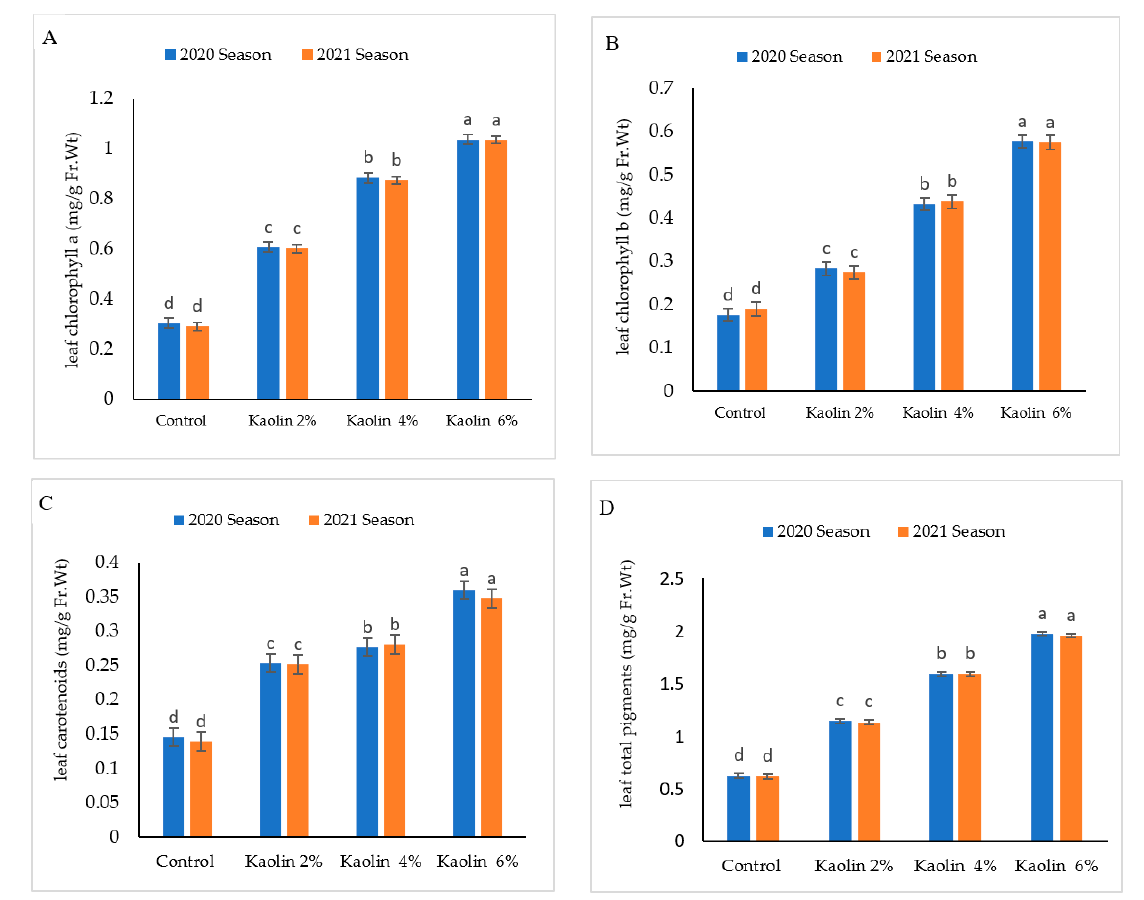
Figure 3. Effect of kaolin spray on: ( A ) leaf chlorophyll a (mg/g Fr.Wt), ( B ) leaf chlorophyll b (mg/g Fr.Wt), ( C ) leaf carotenoids (mg/g Fr.Wt) and ( D ) leaf total pigments (mg/g F.W) of Keitt mango cultivar during the seasons 2020 and 2021. Bars indicate mean values ± SE (n = 9). Different letters above columns indicate significant differences among pruning treatments at p = 0.05 according to Bartlett’s test.